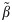
Summary and unified model of pseudopod extension.(A) Schematic of pseudopod extension for all stains and conditions. An excitable system triggers the START of pseudopod extension with rate constant α. Each extending pseudopod inhibits the start of a new pseudopod A-fold. The pseudopod extends at a rate v, thereby -with time t- reaching a larger size s. The STOP of the pseudopod is mediated by processes that depends on a combination of rate, time and size; together they represent a macroscopic rate constant of stopping β˜. The relative contribution of rate, time and size to STOP is given for polarized Dictyostelium cells. Panels B and C present a physical model. (B) The strong polymerization of branched F-actin (bF-actin) induces a forward force; at the start of pseudopod extension, the force F0 is mediated by about 4000 bF-actin filament at the emerging tip (see S6 Fig in S1 File). (C) The experiments reveal that multiple counterforces contribute to pseudopod STOP; see text for details. Panels D-G presents the outcome of mutant analysis in Dictyostelium. (E) The extending pseudopod. In Dictyostelium a Ras-bF-actin-excitable system triggers pseudopod extension by activating Rac1 and the Scar complex, which induces Arp2/3-mediated actin nucleation and branching; scar-null cells stop prematurely. (F) Inhibition of new pseudopods. The cortex is a ~100 nm thick sheet under the plasma membrane consisting of parallel F-actin filaments (pF-actin), myosin filament and additional F-actin-binding proteins; formins stimulate and stabilize the pF-actin/myosin structure. Branched-F-actin is not easily formed in a strong cortex. Observations reveal that an extending pseudopod very fast generates an unknown global signal X that inhibits new pseudopods. This inhibition requires RacE and the pF-actin/formin/myosin cortex (cluster a in S7 Fig in S1 File). (G) The uropod. In Dictyostelium, a cGMP-based signaling pathway activates the interaction between myosin filaments and pF-actin filaments, leading to contraction of the uropod. Pseudopods that extend at a very high rate stop prematurely in cells with a very strong uropod (cluster b in S7 Fig in S1 File). In mammalian cells the three major components of the cell -pseudopod, cortex and uropod- play similar roles as in Dictyostelium, but the excitable system in panel E may have other small GTP-proteins such as CDC42, and the uropod in panel G is not regulated by cGMP but by the Rho-kinase Rock.